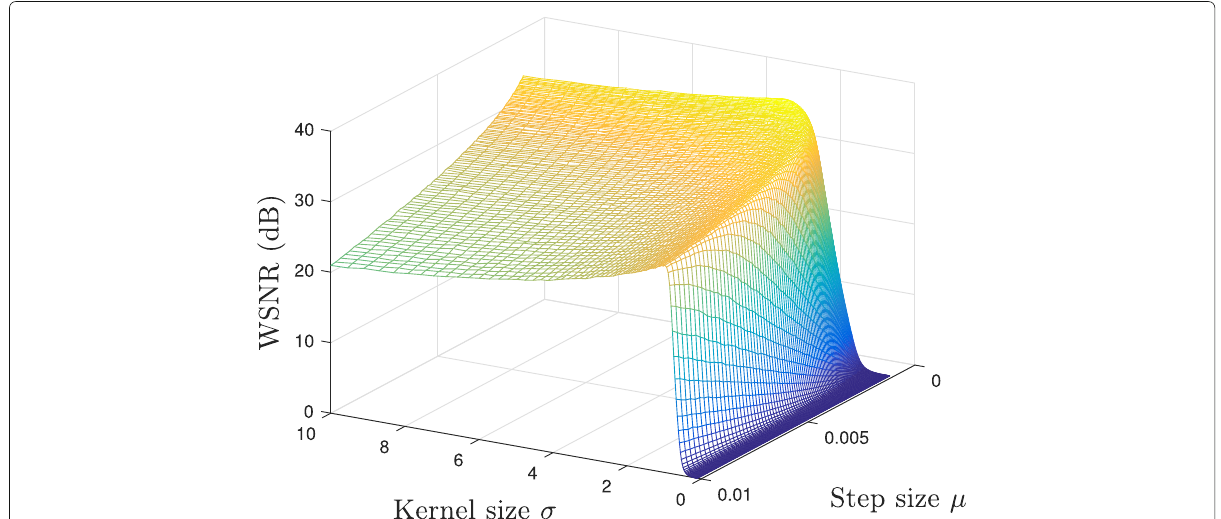
Fig. 8 WSNR performance of the CVKW algorithm as a function of the kernel size parameter σ and the gradient step size μ . The noise environment is model by a stable distribution with α = 1.5 and GSNR = 20